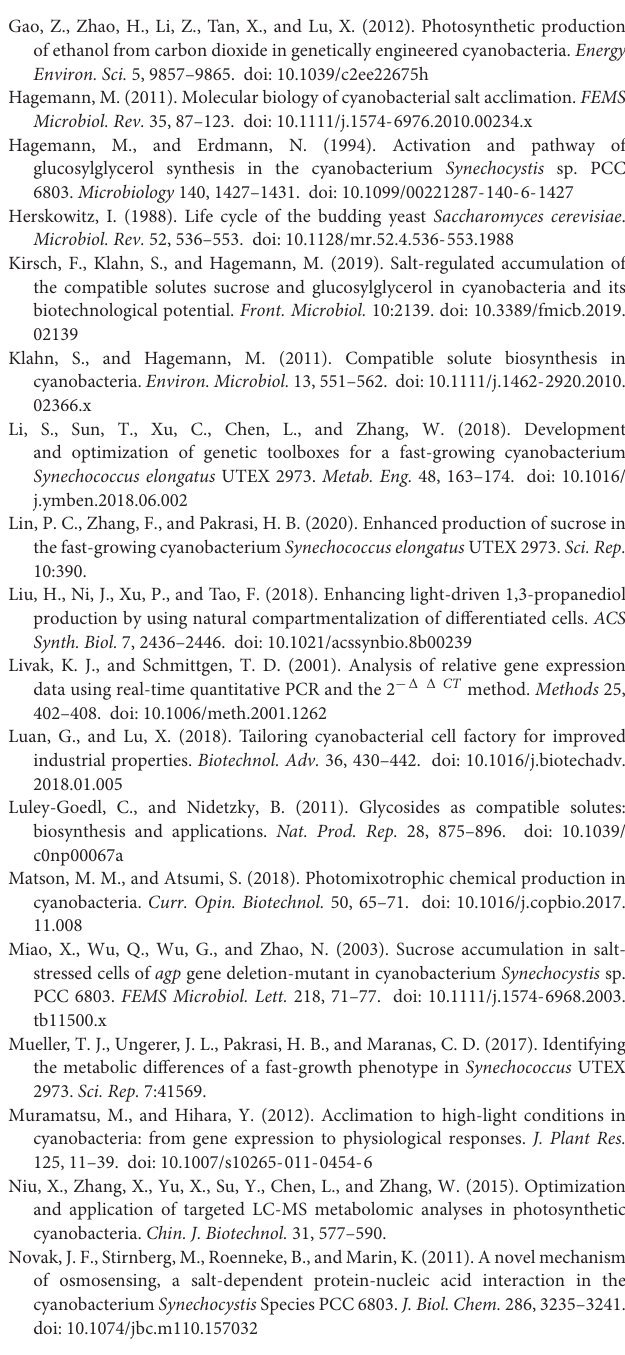
Supplementary Figure 2 | GG production at different cultivation points of strain M-GgpPS. Supplementary Figure 3 | Chromatograms of GG, sucrose and internal standard 13C-sorbitol. (A) Chromatogram of the derivatized 13C-sorbitol and GG standard; (B) chromatogram of control strain M-pSI; (C) chromatogram of strain M-GgpPS; (D) mass spectrometry of GG. Supplementary Figure 4 | Transcript level measurements of glgA , rfbA , and Syn0808 in strains M-GgpPS (orange) and M-pSI (black) using qRT-PCR.